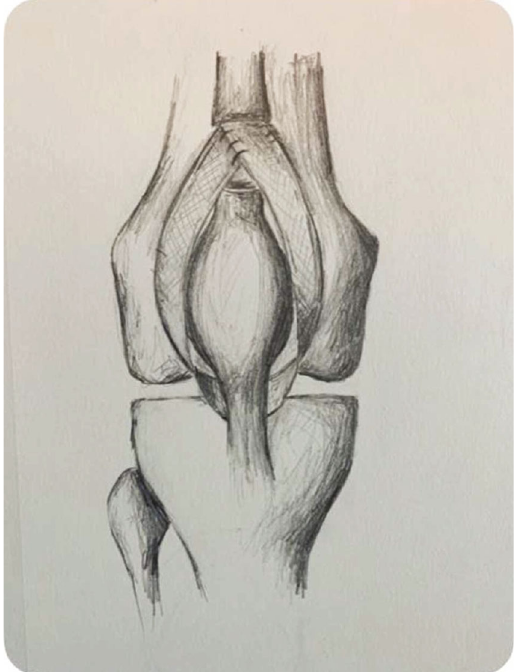
Figure 5: Illustration of preparation of transpatellar tendon tunnel for mesh passage and distal fi xation.